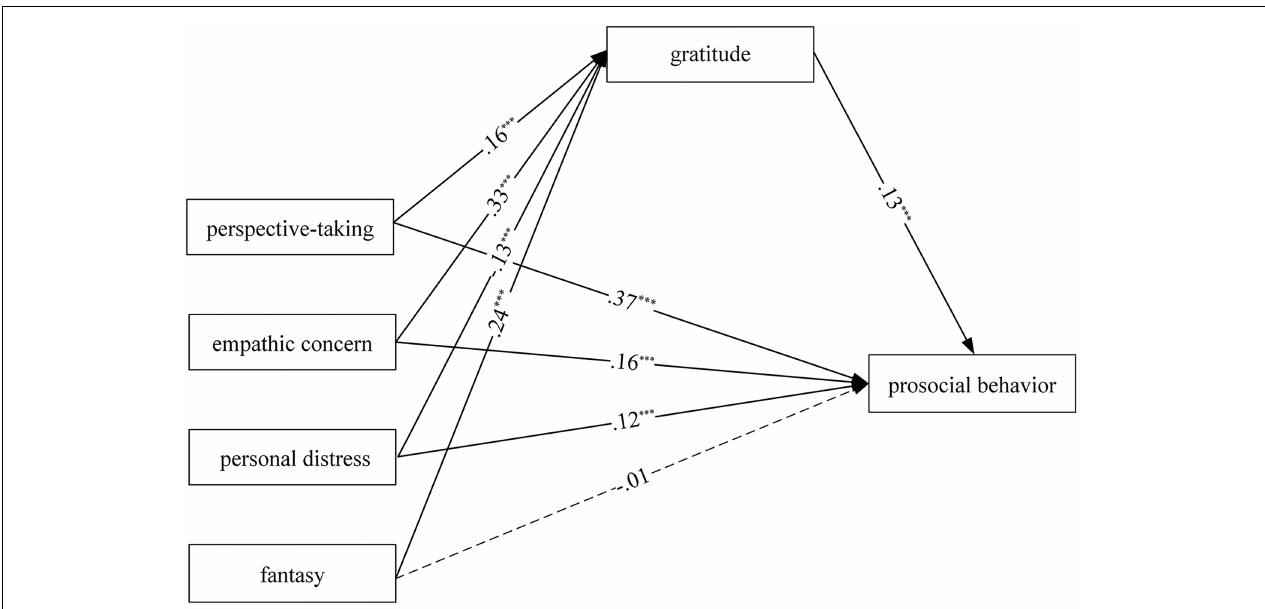
FIGURE 1 | The mediation model. Path coefficients are standardized coefficients. *** p < 0.001.